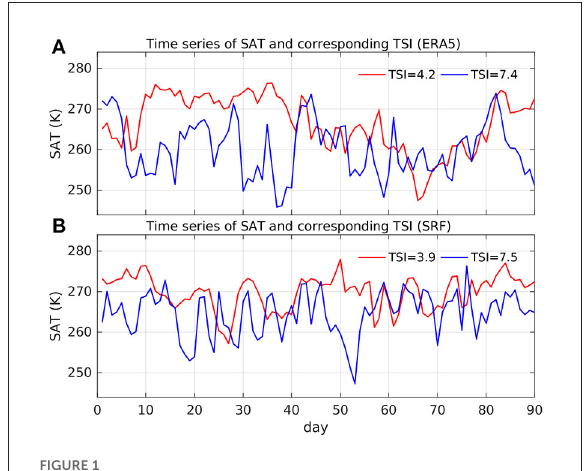
FIGURE1 Illustration of daily SAT time series and corresponding TSI at a mid-latitude location (90 ◦ W, 45 ◦ N) in the United States for two contrasting seasons with weak (red) and strong (blue) temperature swings from (A) ERA5 data and (B) SRF. The corresponding TSI values are prescribed in each line caption. Units of SAT and TSI are